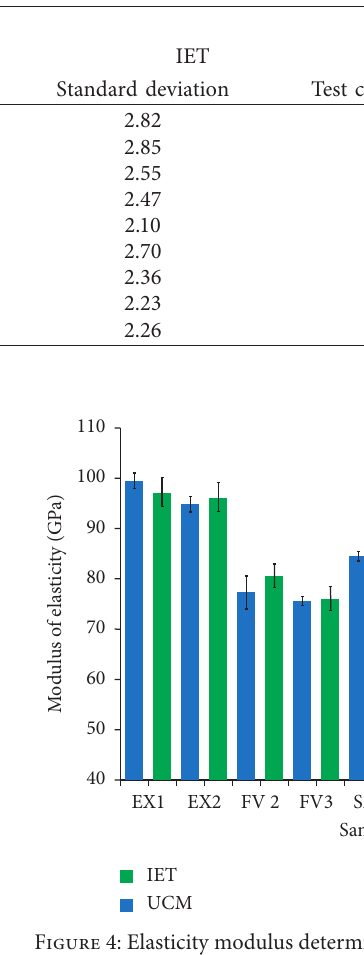
Figure 3: Stress-strain curve of sample EX1 for 3-load uniaxial compression test in EX1. Table 4: Young’s modulus yielded by IET and UCM.